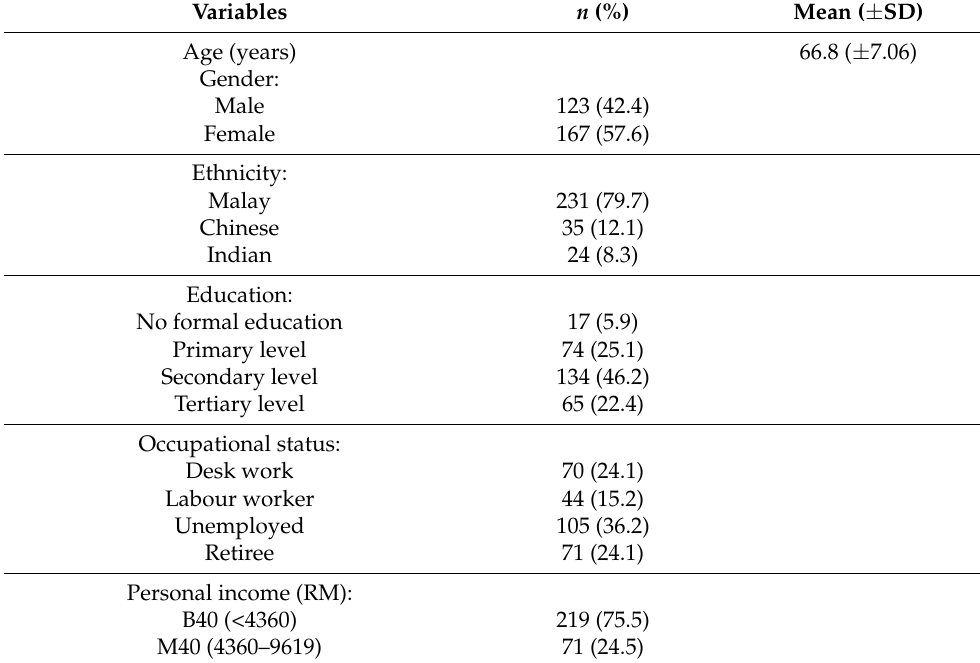
Table 2. Sociodemographic characteristics and knee OA profiles of the